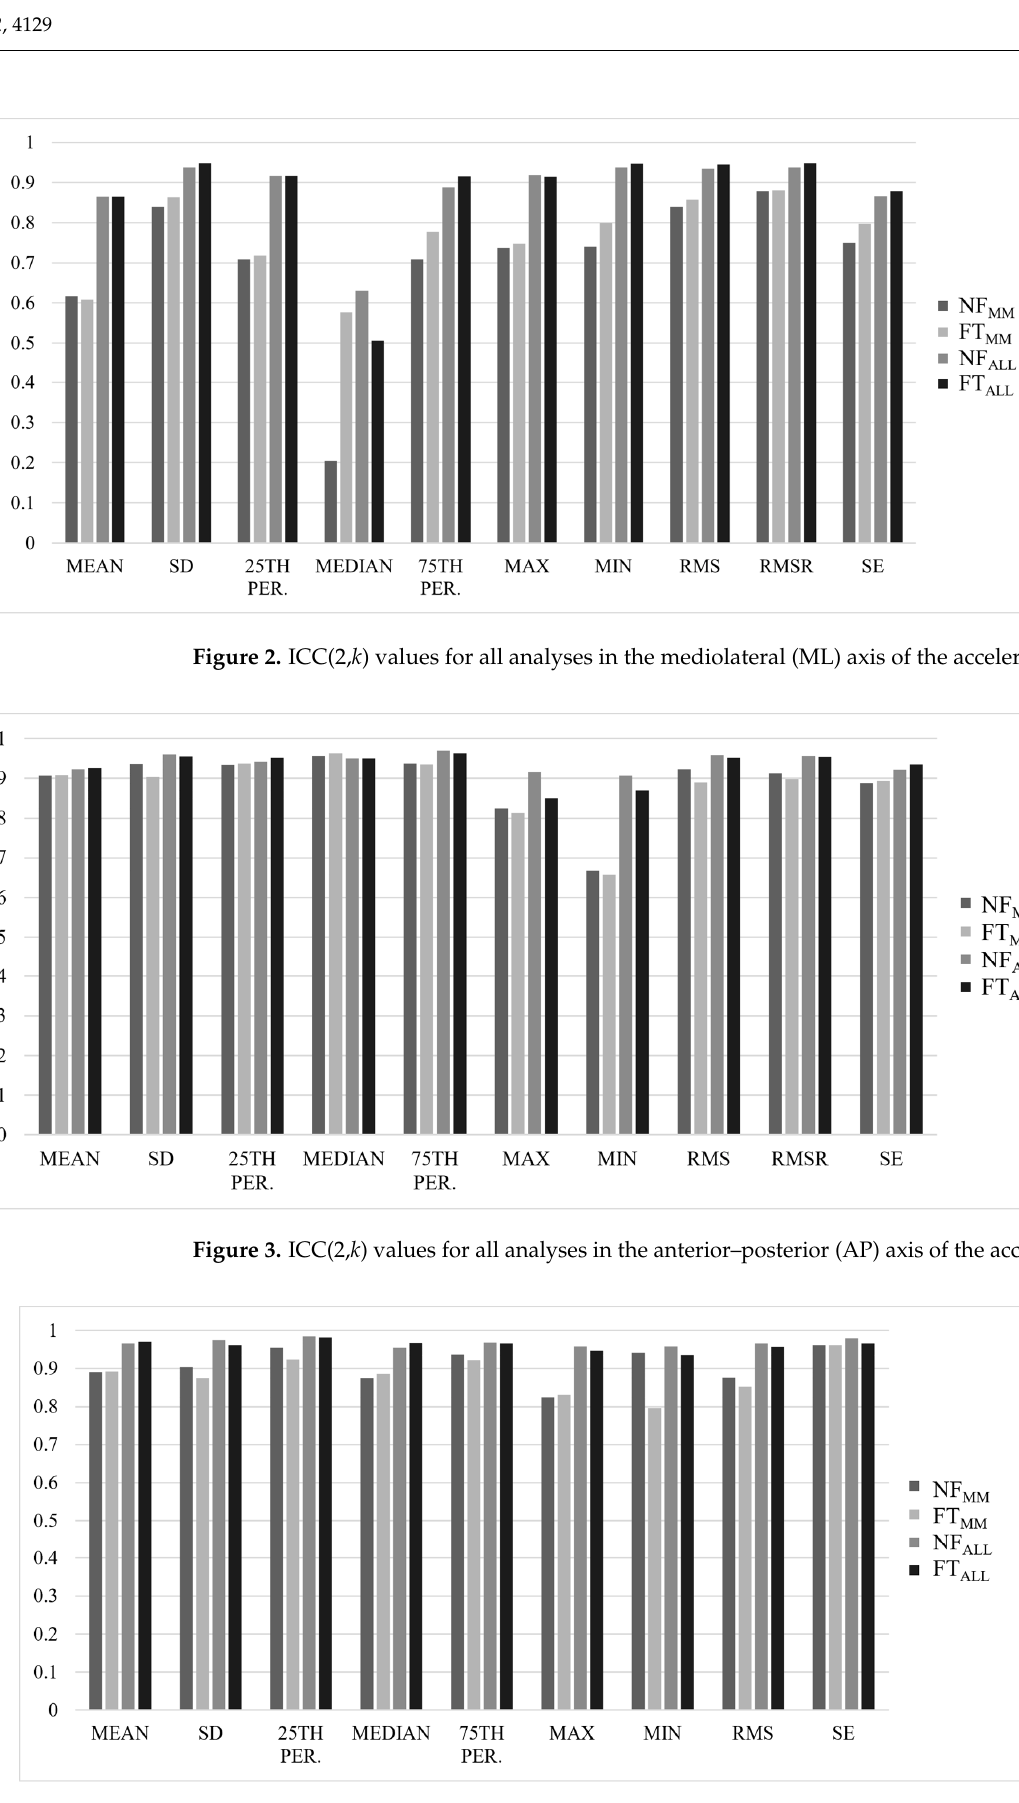
Figure 4. ICC(2,k) values for all analyses in the resultant (RES) of the acceleration